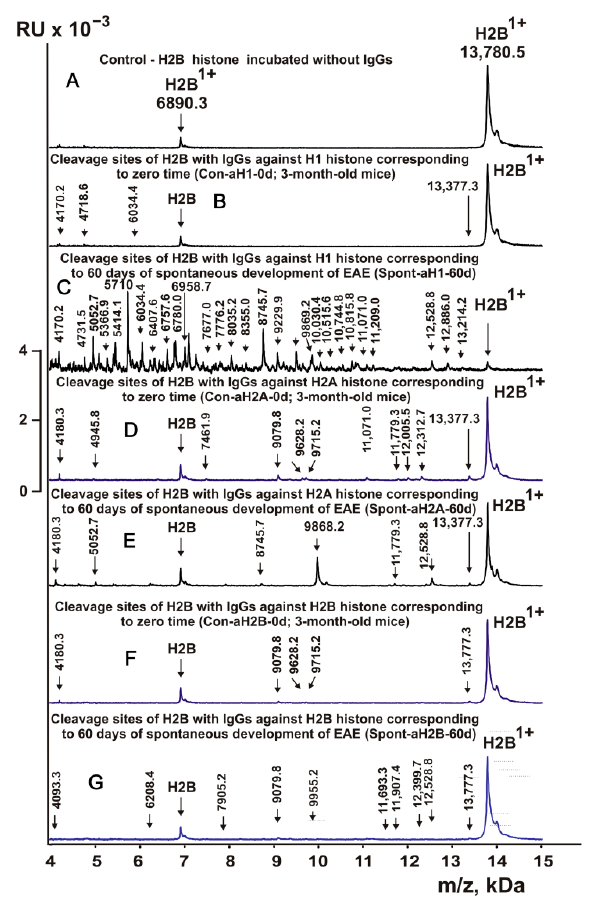
Figure 2. MALDI spectra corresponding to products of H2B histone (0.9 mg/mL) hydrolysis in the absence ( A ) or presence of IgGs (0.04 mg/mL) against three histones: control (H2B incubated without Abs) ( A ), Con-aH1-0d ( B ), Spont-aH1-60d ( C ), Con-aH2A-0d ( D ), Spont-aH2A-60d ( E ), Con-aH2B-0d ( F ), and Spont-aHB-60d ( G ). All designations of IgG preparations and values of m / z are shown in the